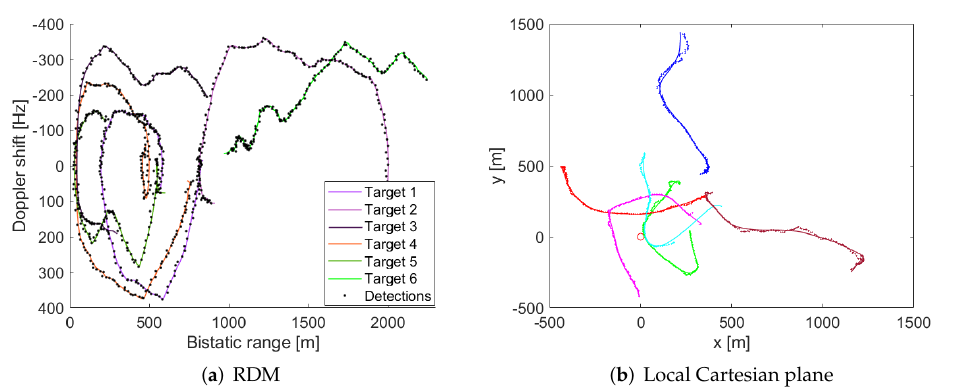
Figure 8. Results for the simulated radar scenario: ( a ) confirmed detections and associated tracks in the measurement space (range-Doppler); ( b ) Cartesian space tracking results (+ marker) and reference targets’ path presented in Figure 7 (solid line).